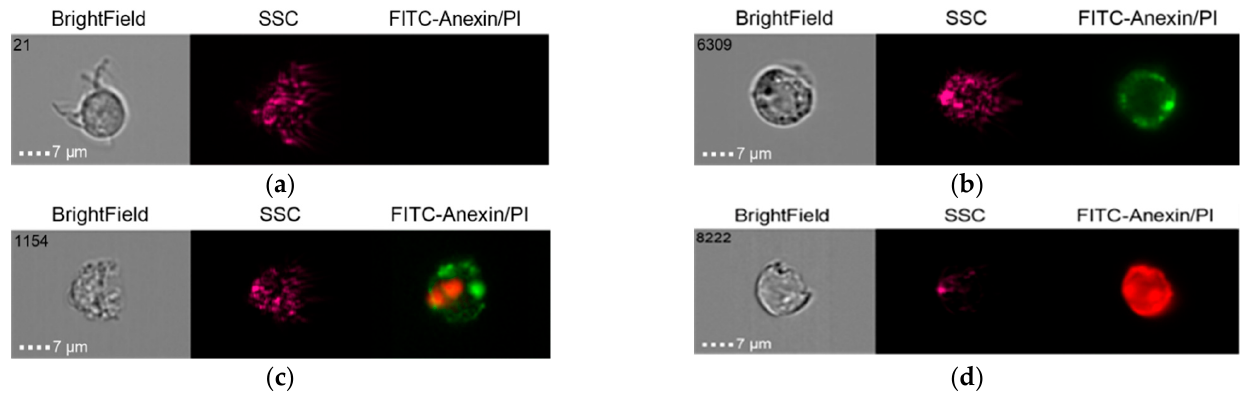
Figure 6. Live cells ( a ), early apoptosis ( b ), late apoptosis ( c ), necrosis ( d ) after co-culture of Nobel Replace NSMP with THP-1 cell line (Nobel Replace NSMP + DSP + THP-1).